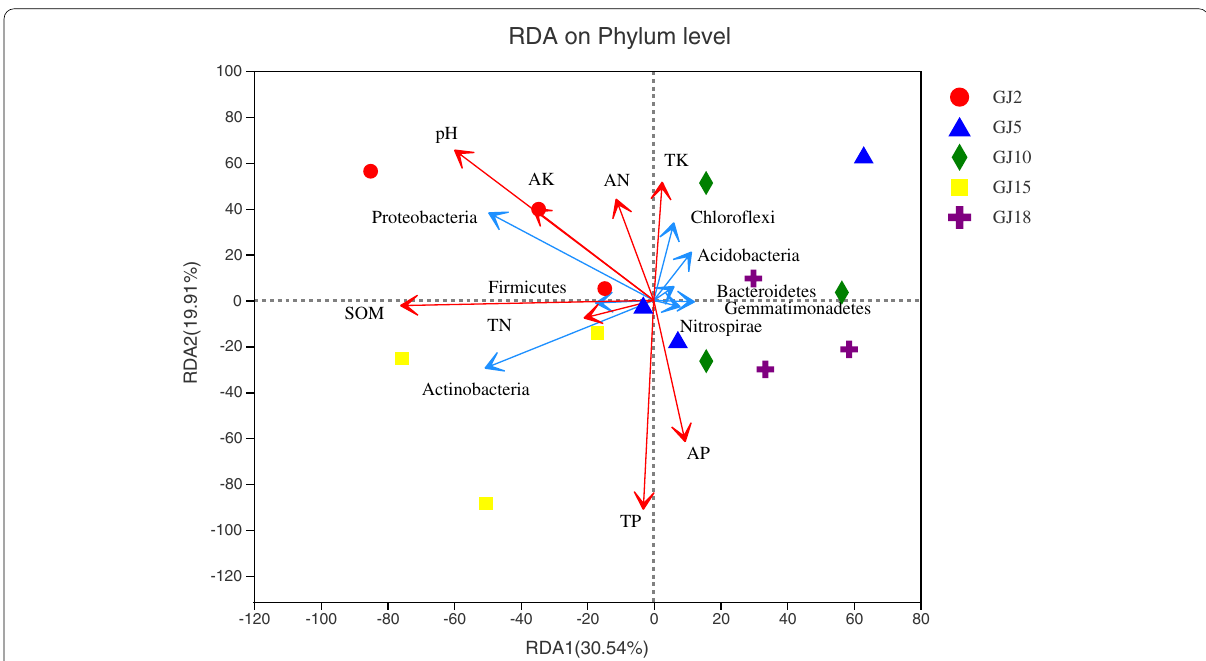
Fig. 7 Soil bacterial community and soil factors in citrus orchards with different ages. Red arrows indicate the direction and impact degree of environmental factors; the angle between them represents positive and negative correlation (acute angle indicate positive correlation; obtuse angle indicate negative correlation; straight angle indicate no correlation)